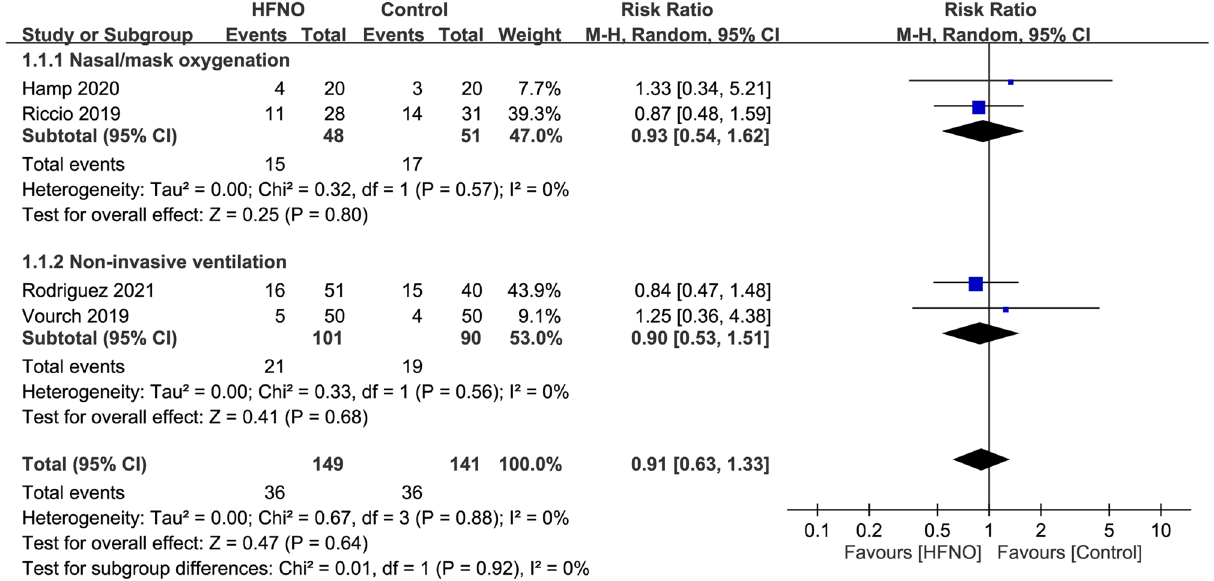
Figure 3. Forest plot comparing the risk of hypoxemia between HFNO and control groups. HFNO, high-flow nasal oxygenation; M-H, Mantel–Haenszel; CI, confidence